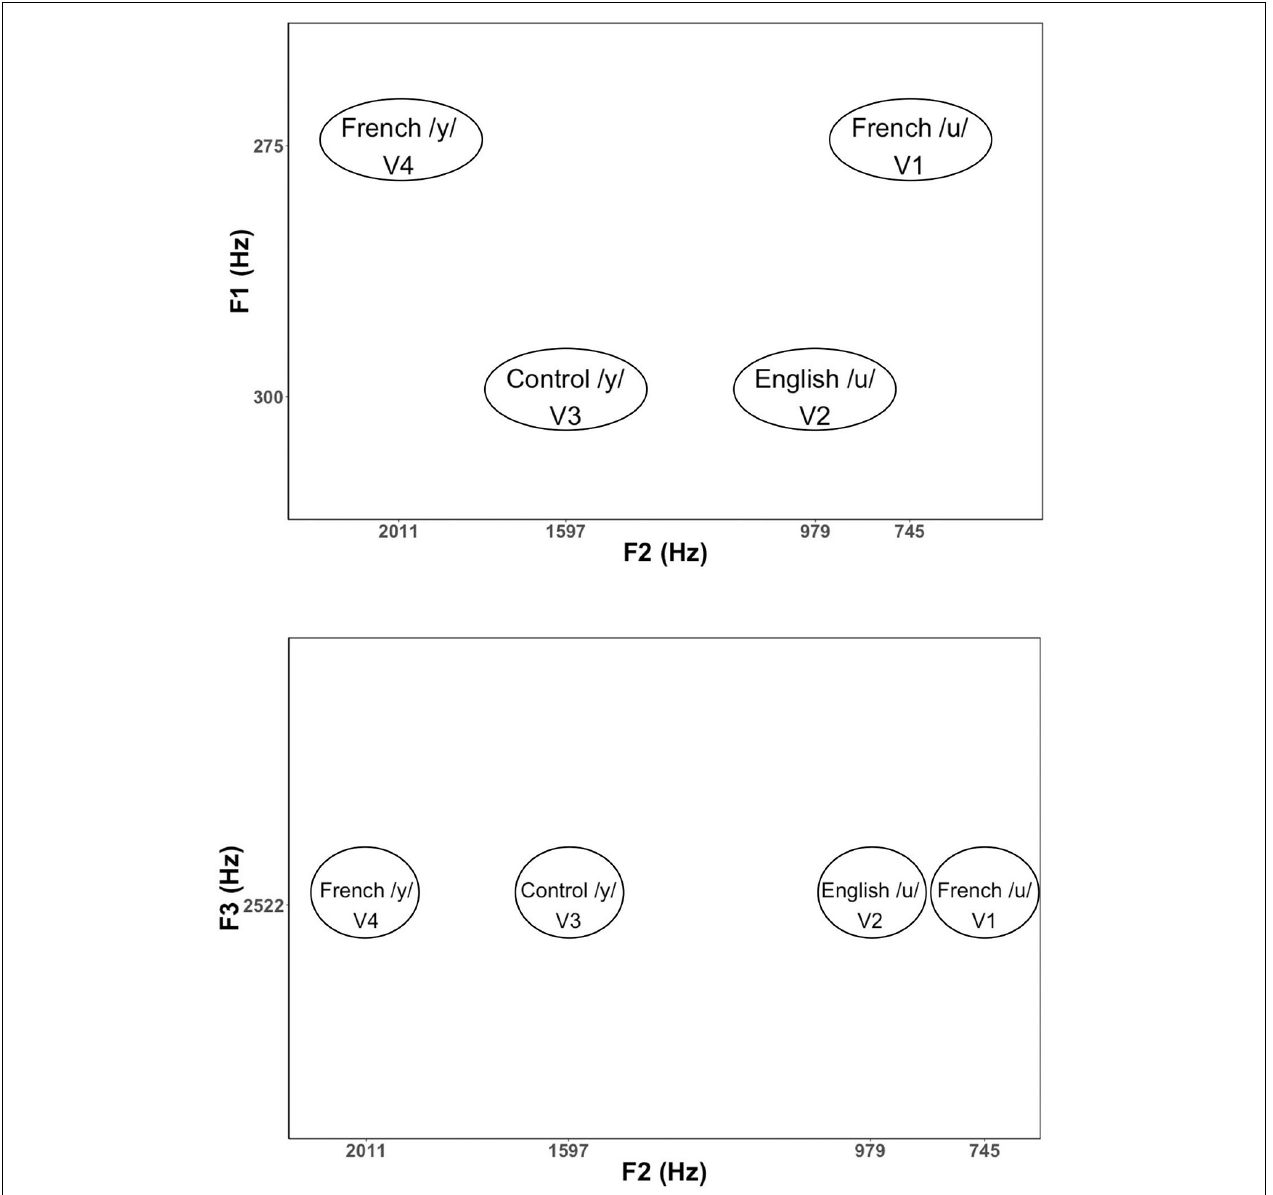
FIGURE 1 | Formant values for the vowel stimuli in F 1 –F 2 and F 2 –F 3 spaces. F 1 is related to the degree of constriction formed by the tongue in the vocal tract with lower F 1 values corresponding to a tighter constriction formed by a higher tongue position. F 2 is related to the location of the tongue constriction along the length of the vocal tract, with higher F 2 values corresponding to constrictions closer to the lips. Lip rounding (lip compression and protrusion) increases vocal tract length, which in turn, has the effect of lowering all formants, especially F 3